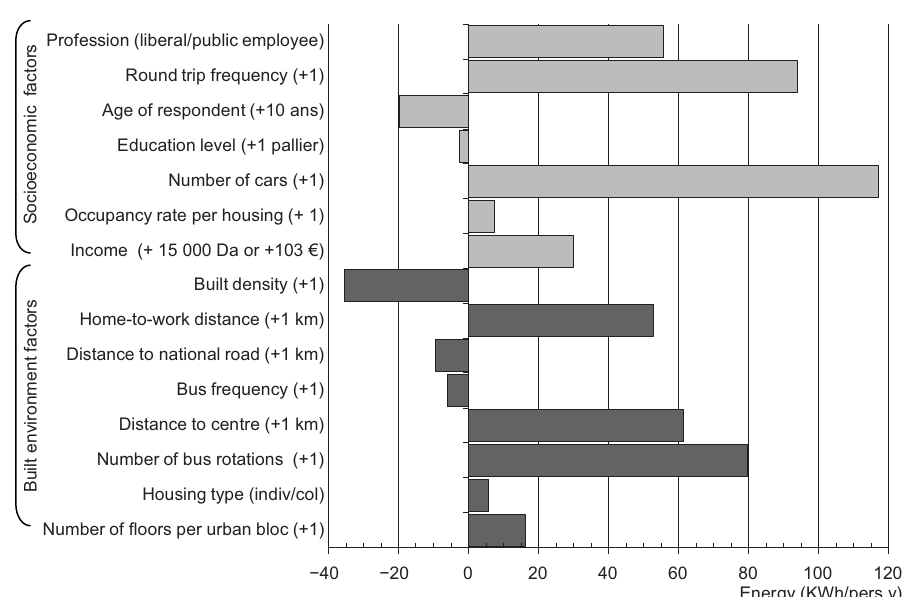
Fig. 7. Effect of SE and BE driving factors per unit of measurement on energy consumption of commuting to